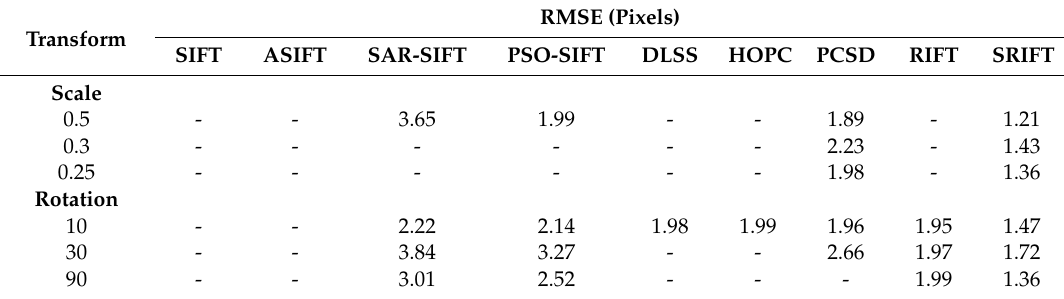
Table 2. RMSE comparison for simulated dataset 2 (Sentinel-1 SAR image and Sentinel-2 optical image). Transform